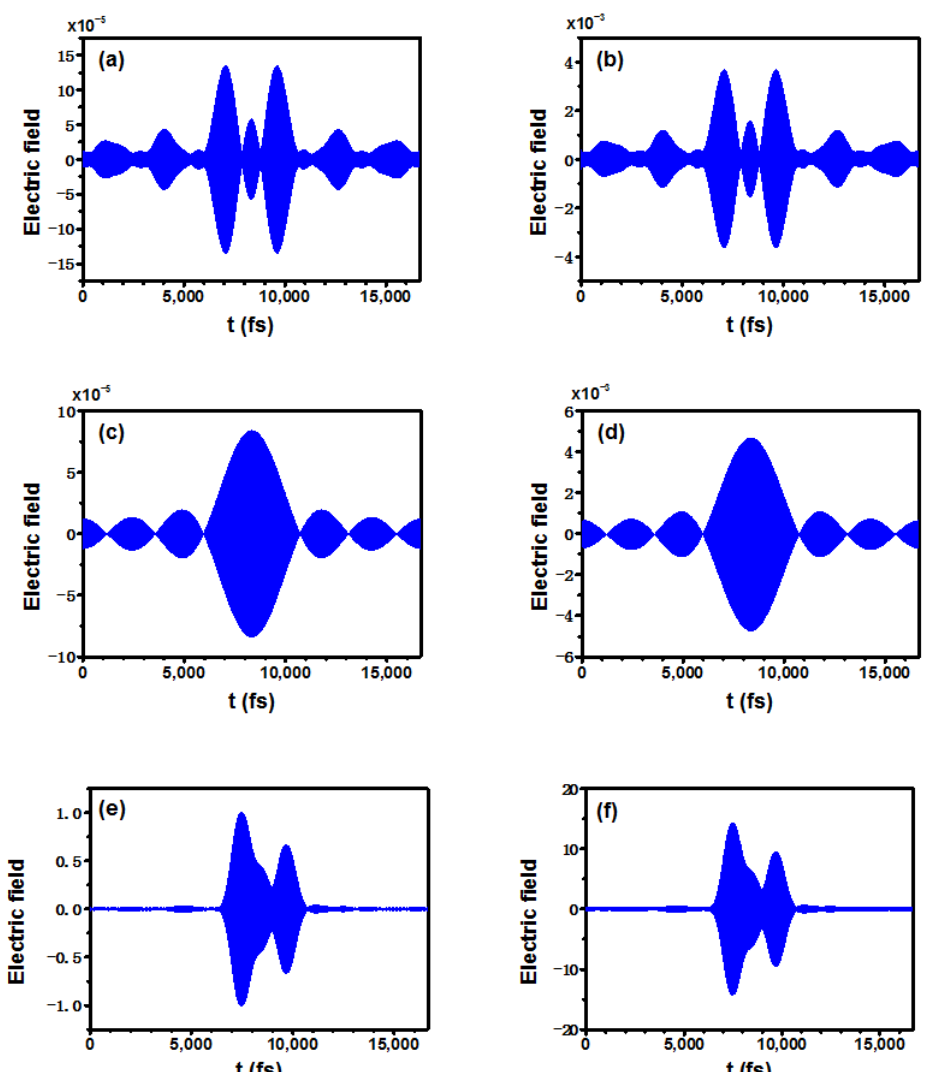
Figure A4. Real part of the electric field of ( a , b ) the Stokes, ( c , d ) probe, and ( e , f ) anti-Stokes pf1 pulse, where ( a , c ) are the input pulses, and ( b , d ) are the output pulses at the probe point of the disk-ring structure. The anti-Stokes pulse ( e ) in air and ( f) at the probe point in the disk-ring structure. The responses of the Stokes, probe, and anti-Stokes pulses are also shown in Figure A4b,d,f, respectively. The results of the Stokes and probe pulses are normalized by the